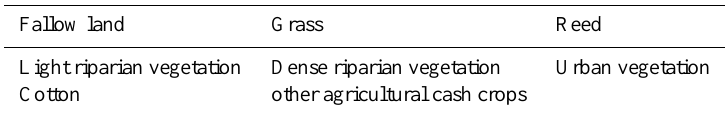
Table 5. Land use